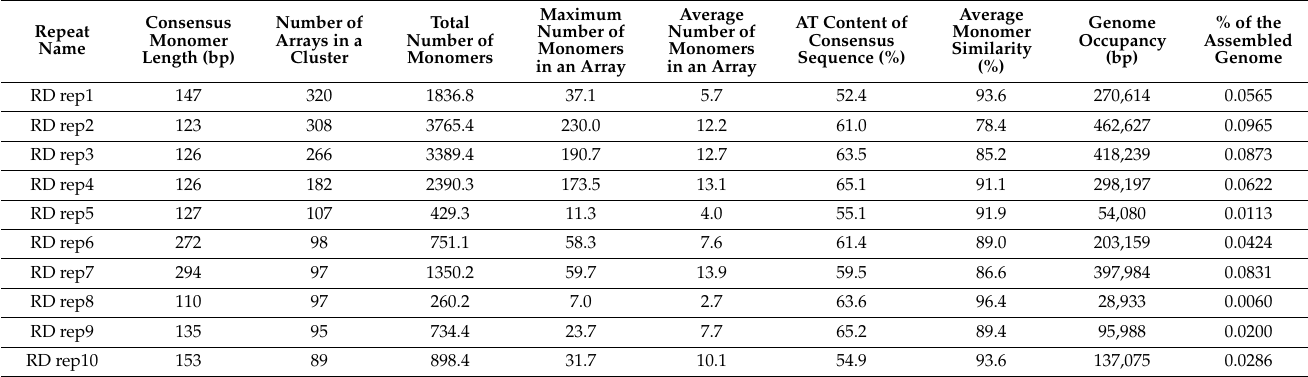
Table 6. Characteristics, organizational properties, and abundance of 10 major families of repeats found in the R. dominica